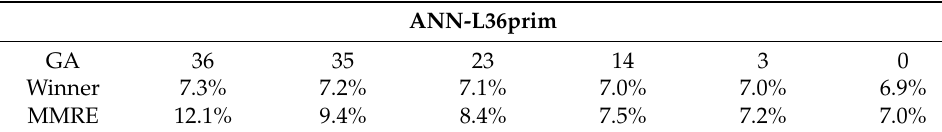
Table 6. ANN-L36prim training results.